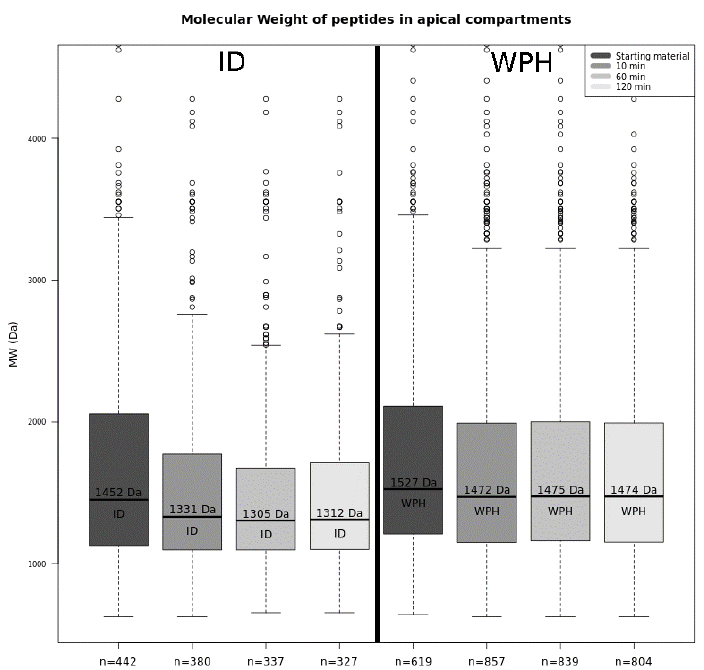
Figure 2. Median molecular weight and total number of peptides found in digested (ID) and undigested (WPH) whey hydrolysate following UC absorption in apical compartments progressing from 0 to 120 min.